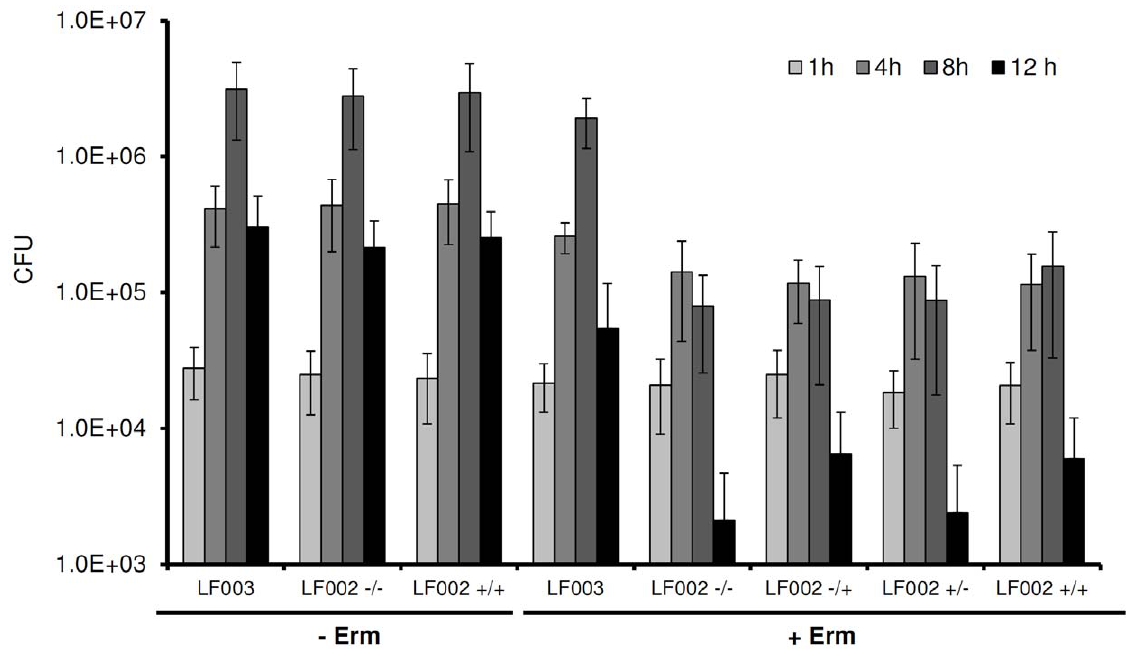
Figure 5. Intracellular multiplication of L.monocytogenes LF002 ( ermC under control of P rha ) in human THP1 macrophages, in the presence and absence of rhamnose and erythromycin (see Material and Methods for experimental details). Positive controls without drug addition ( 2 Erm) are in the left columns. Right columns: erythromycin added to infected cells ( + Erm). –/–: non-induced bacteria, no addition of rhamnose after macrophage infection; –/ + : non-induced bacteria, 10 mM rhamnose added after infection; + /–: pre-induced bacteria, no addition of